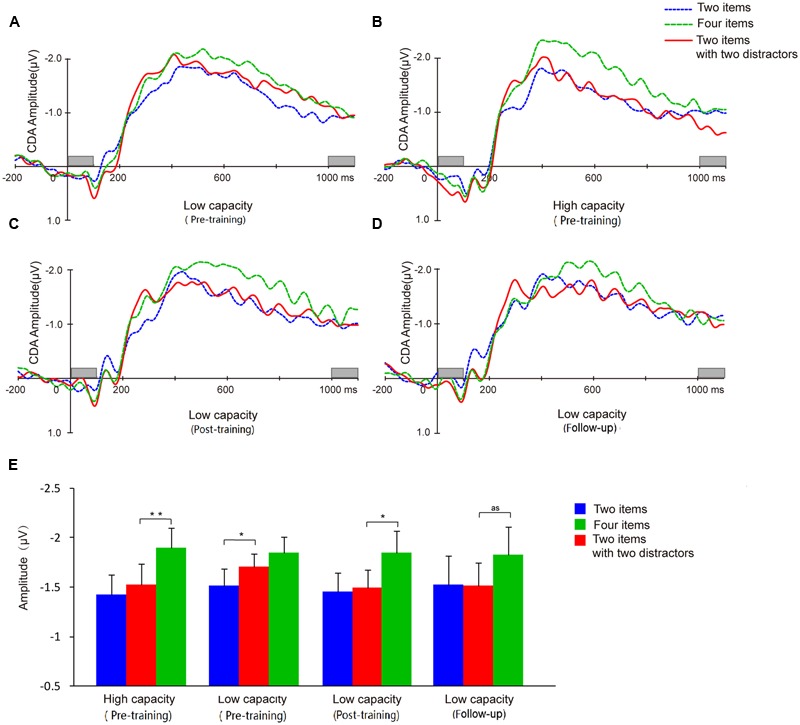
Contralateral delay activity (CDA) waveforms and CDA amplitude means. Grand average ERP difference waves for the low capacity group at pretest (A), posttest (C), and follow-up (D). (B) Grand average ERP difference waves of high capacity individuals at pretest. (E) CDA amplitudes from each of the three conditions for each group at pre-training, post-training, and follow-up. And as means approach significant. Asterisks indicate statistical differences at ∗p < 0.05 or ∗∗p < 0.01.